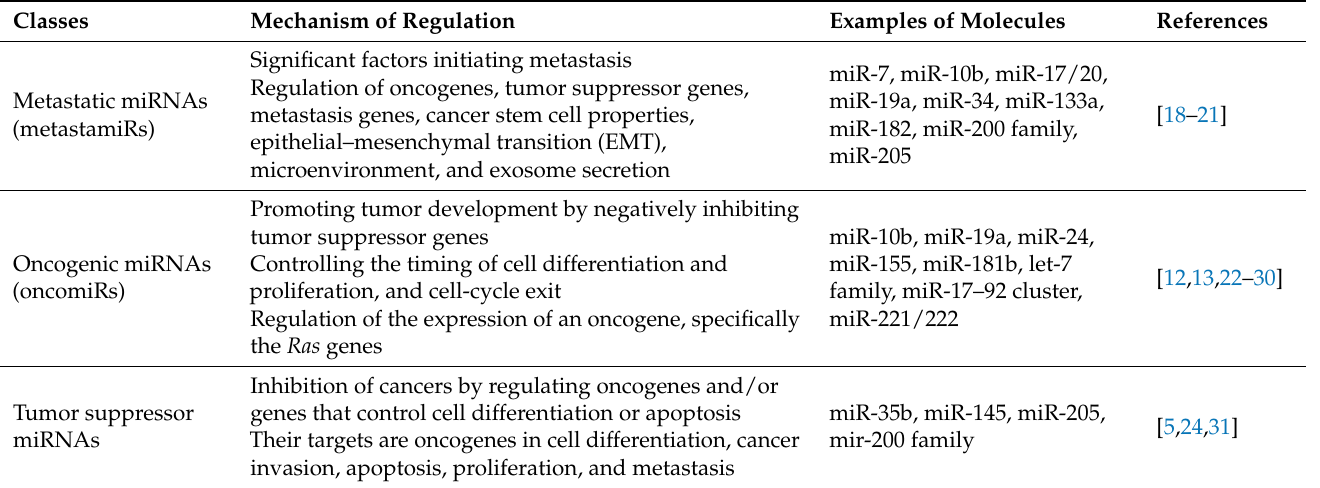
Table 1. Classes of miRNAs in